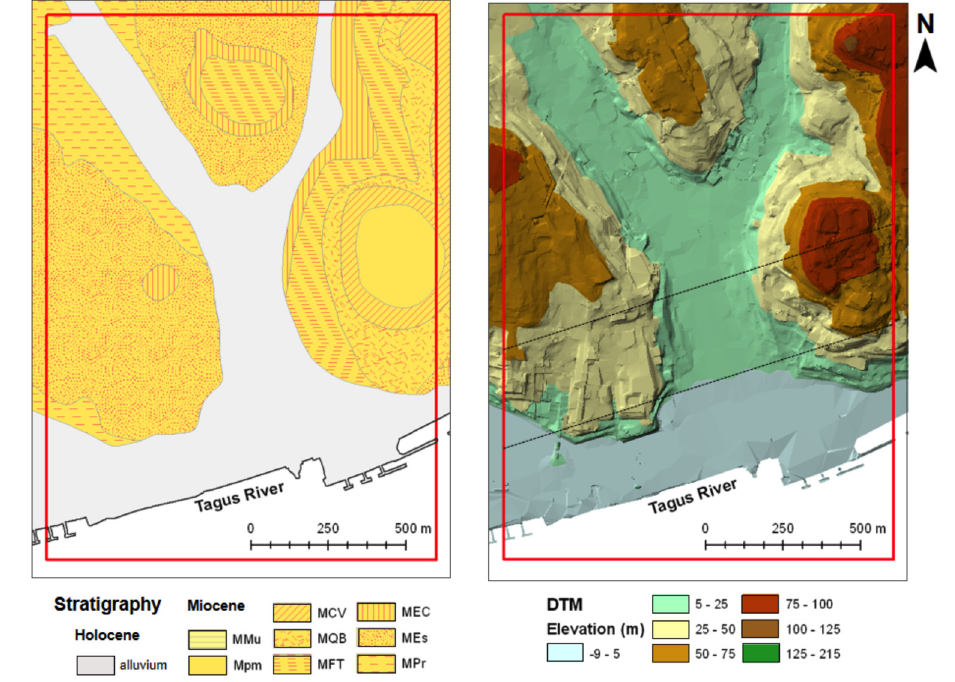
Figure 2. Left: Surface geology of the Baixa area (adapted from Pais et al. [2006]). The central part is filled by alluvial sediments covering Miocene formations (see lithological composition in the text). Right: Digital terrain model (DTM) obtained from a 1:1000 survey scale. Dashed black lines separate the three defined zones (north, central and